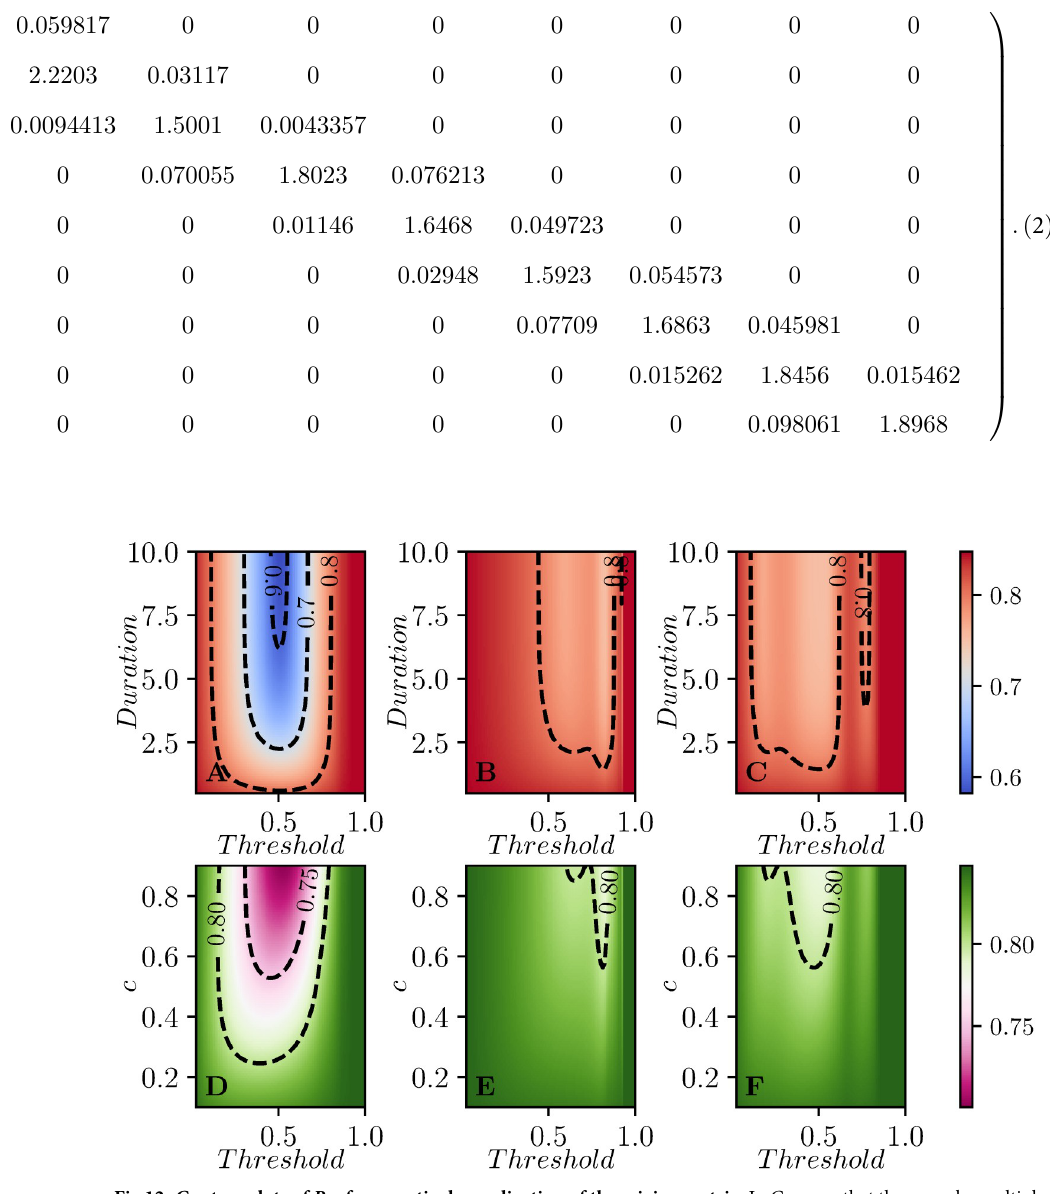
Fig 12. Contourplots of R 1 for a particular realization of the mixing matrix. In C we see that there can be multiple peaks in the optimal time [this is also present in B but it is too small to see]. This is because the effectiveness of the interventions depend on the timing of epidemics in the different subpopulations and these are asynchronous.